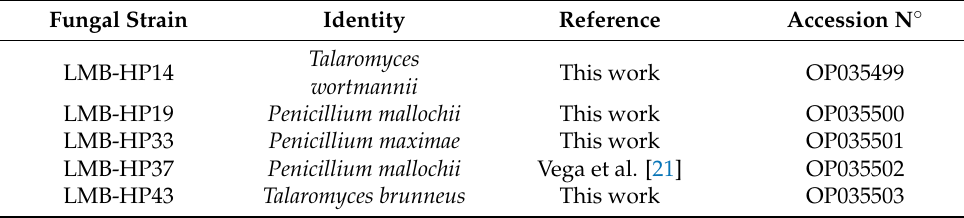
Figure 1. Selected pigment-producing strains after 7 days at 28 °C. Potato Dextrose Agar (PDA) plates showing the obverse ( A ) and reverse ( B ) of fungal colonies. ( C ) Liquid cultures with Potato Dextrose Broth (PDB). Table 1. Fungal identities of selected pigment-producing